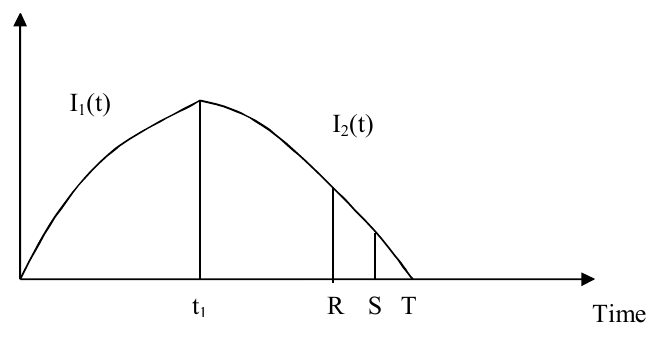
Fig. 3. Inventory versus time (Case-3: T ≥ S